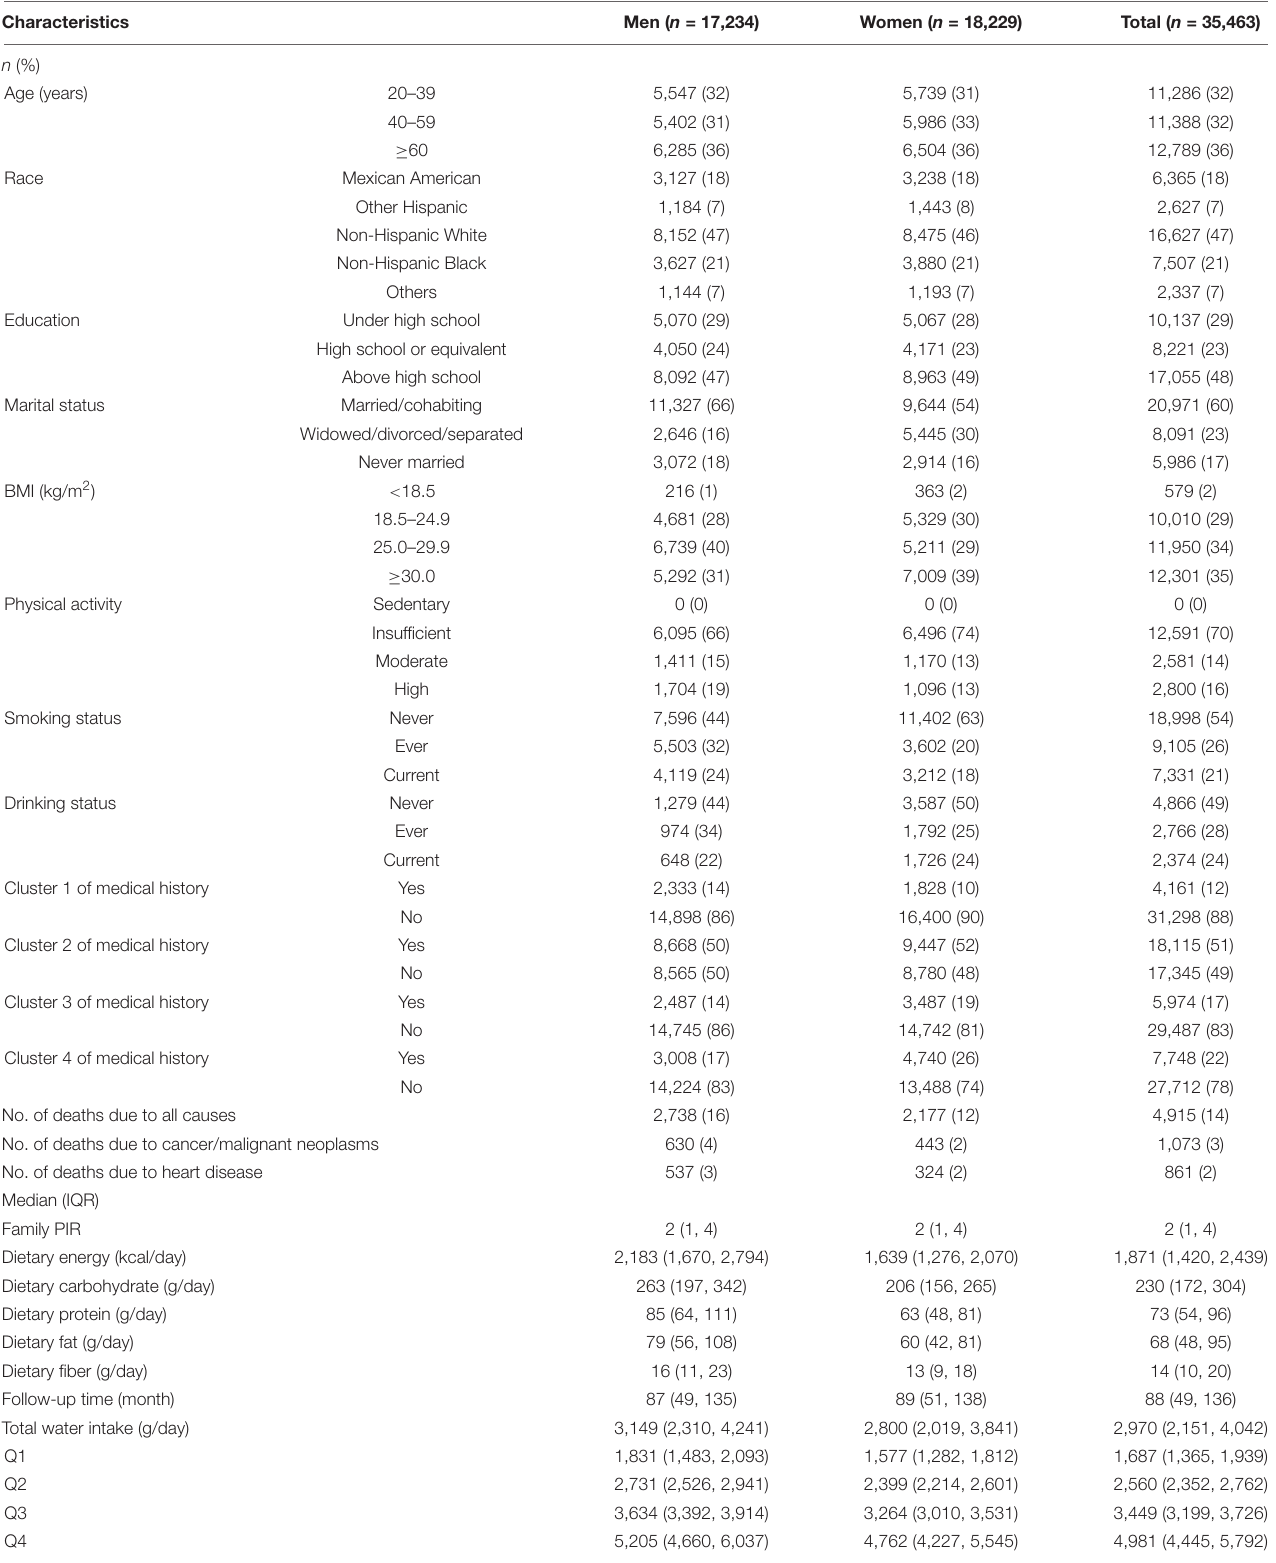
TABLE 1 | General characteristics of participants at the baseline grouped by gender (NHANES 1999–2014).